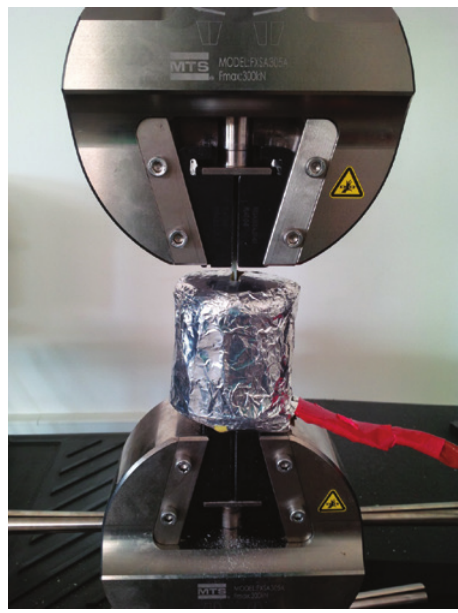
Figure 4: Tensile tests performed at high temperatures via the high- capacity resistance